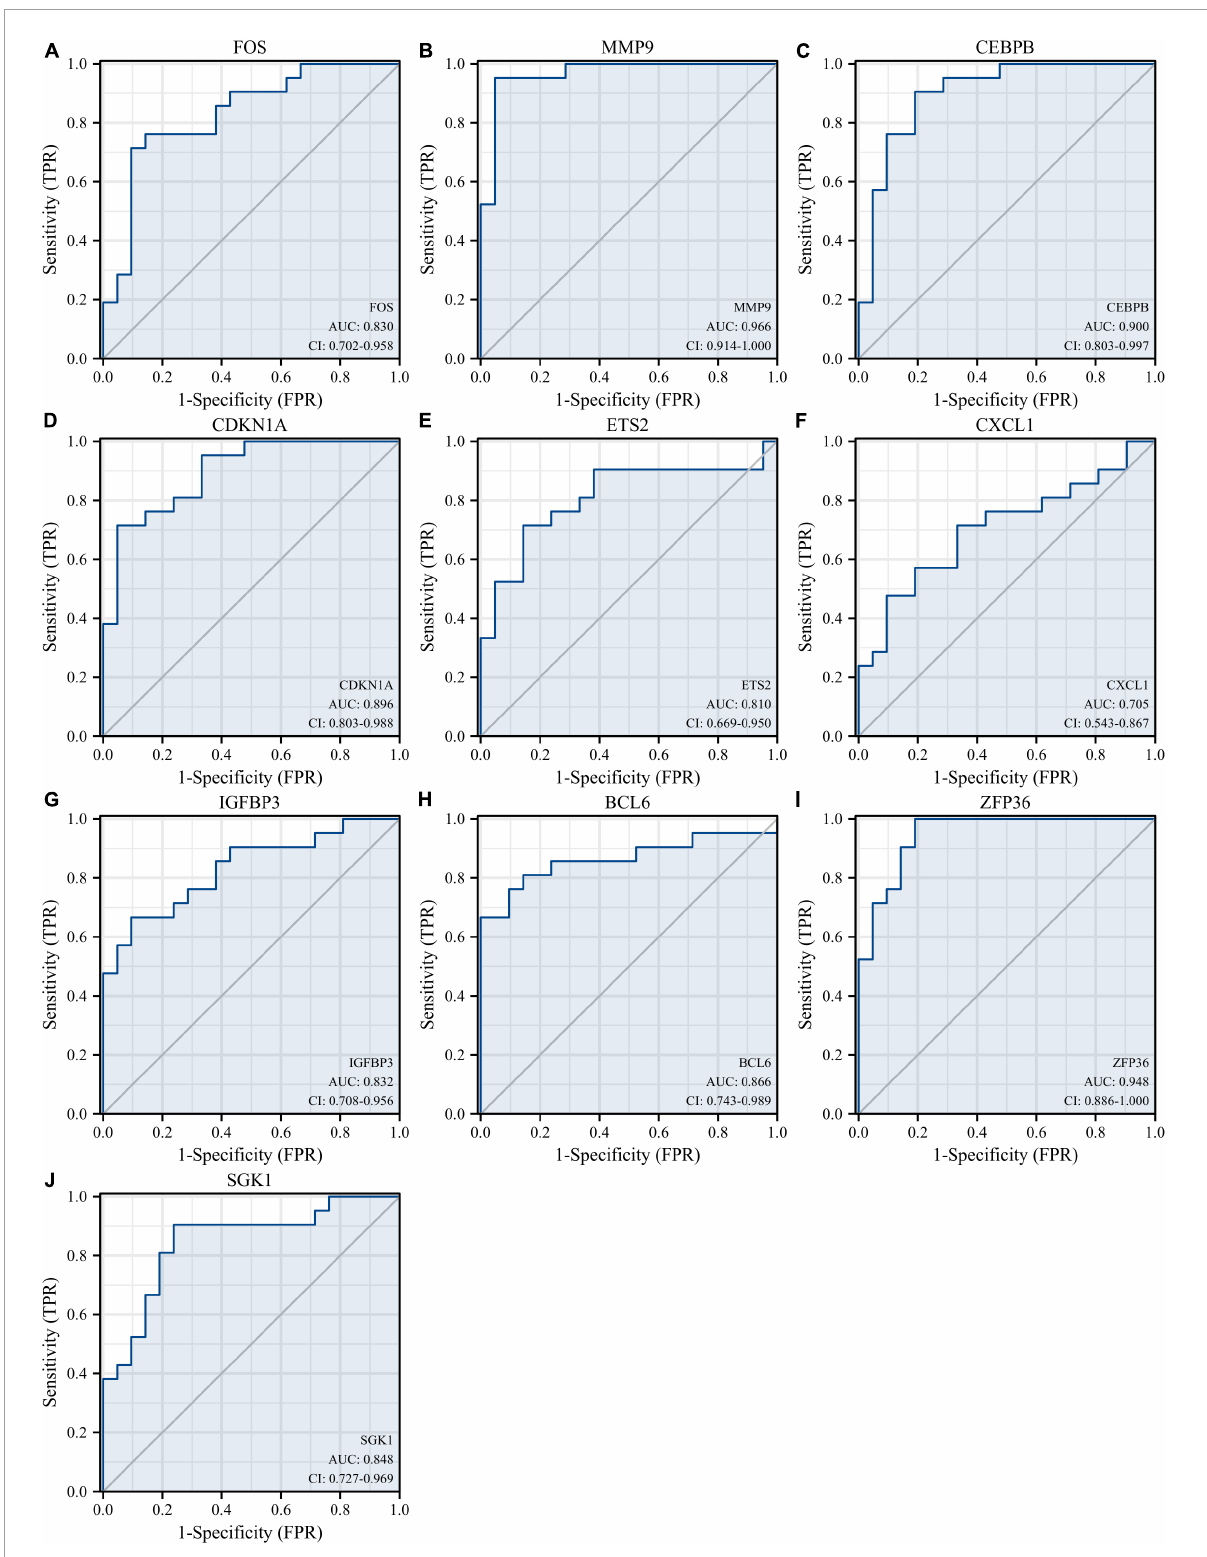
FIGURE8 Diagnostic value of 10 hub genes in the GSE66360 training set. ROC curves of FOS (A) , MMP9 (B) , CEBPB (C) , CDKN1A (D) , ETS2 (E) , CXCL1 (F) , IGFBP3 (G) , BCL6 (H) , ZFP36 (I) , and SGK1 (J) . ROC, receiver operating characteristic.